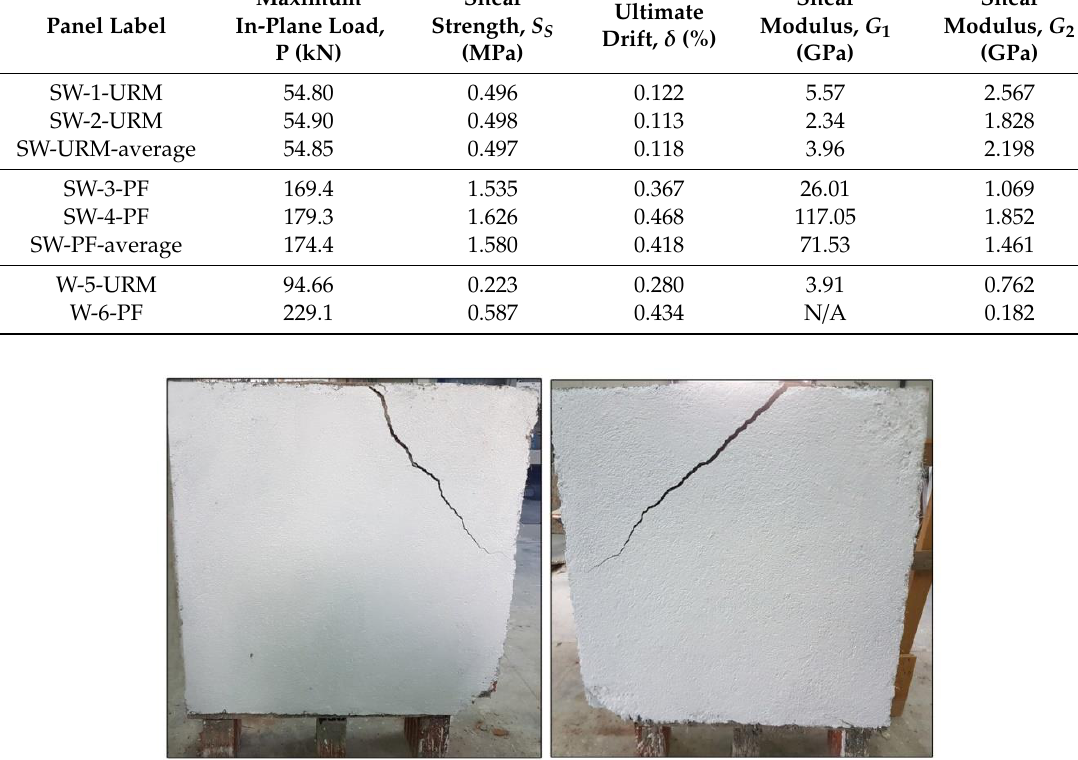
Figure 18. Failure mode of SW-3-PF.